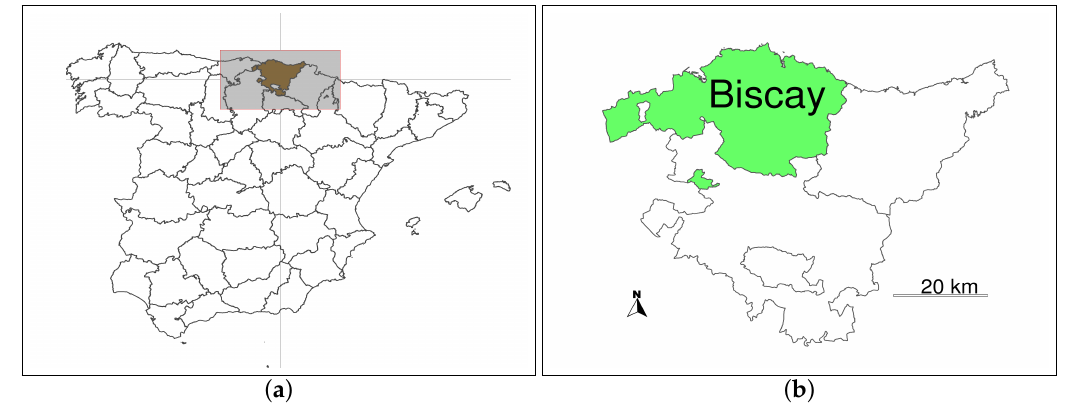
Figure 1. Map of the province of Biscay (Spain). ( a ) Spain; ( b )